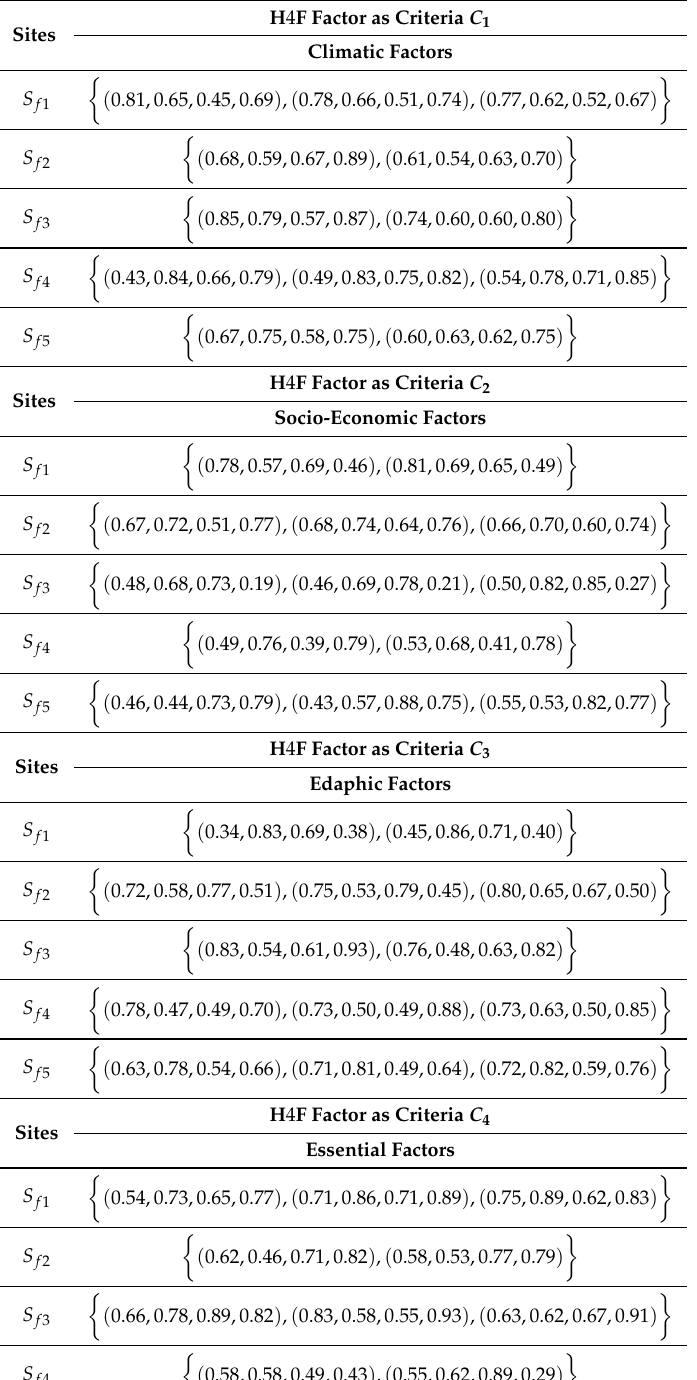
Table 9. Tabular representation of H4F decision